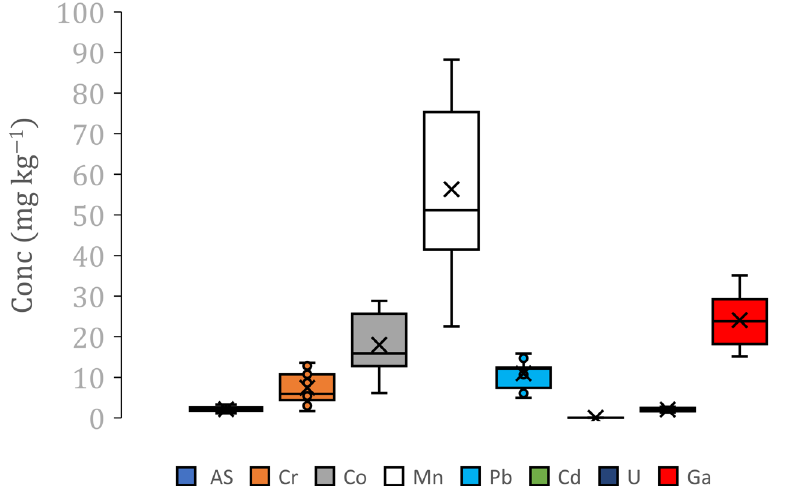
Figure 3. Mean soil metal(loids) concentrations showing countrywide mean As, Cd, Co, Cr (X 10 1 ), Mn (X 10 1 ), Pb, U, and Ga (mg kg − 1 ) concentrations. The boxes represent first and third quartile range of metal(loids) concentrations. The solid line across a box represents the median concentrations; the cross within the box represents the mean concentration, and whiskers represent minimum and maximum concentrations.